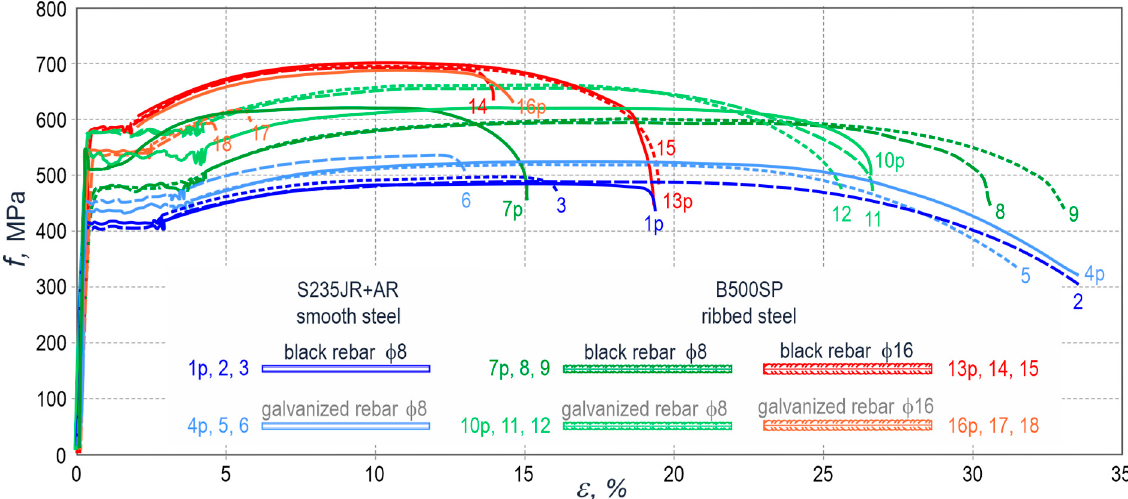
Figure 2. Stress f –strain ε relationship for six types of rebars tested: smooth and ribbed, galvanized, and black steel, with a diameter ϕ 8 mm and ϕ 16 mm, composed of two steel grades; solid lines—the rebars tested after pulling out the specimens from concrete (1p, 4p, 7p, 10p, 13p, 16p), dashed lines—the rebars that were not used in the test elements (2, 3, 5, 6, 8, 9, 11, 12, 14, 15, 17, 18).